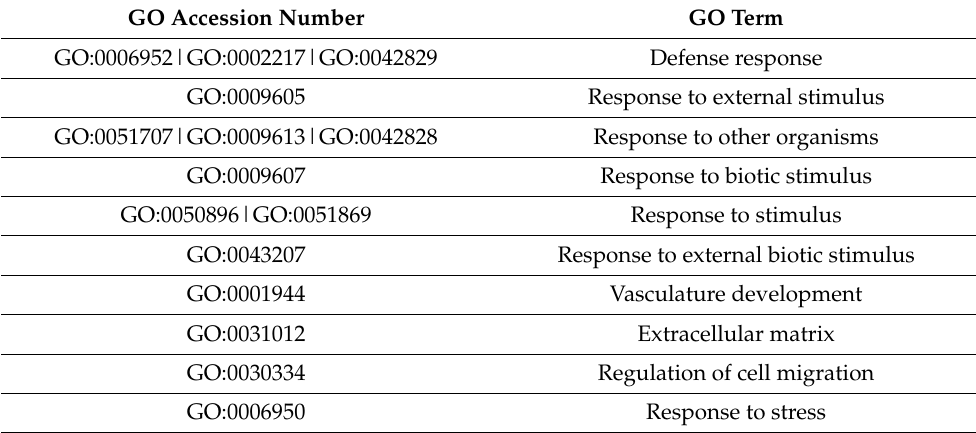
Table 2. Gene Ontology (GO) analysis; 1 W and 2 W > Day 0: > 2.0